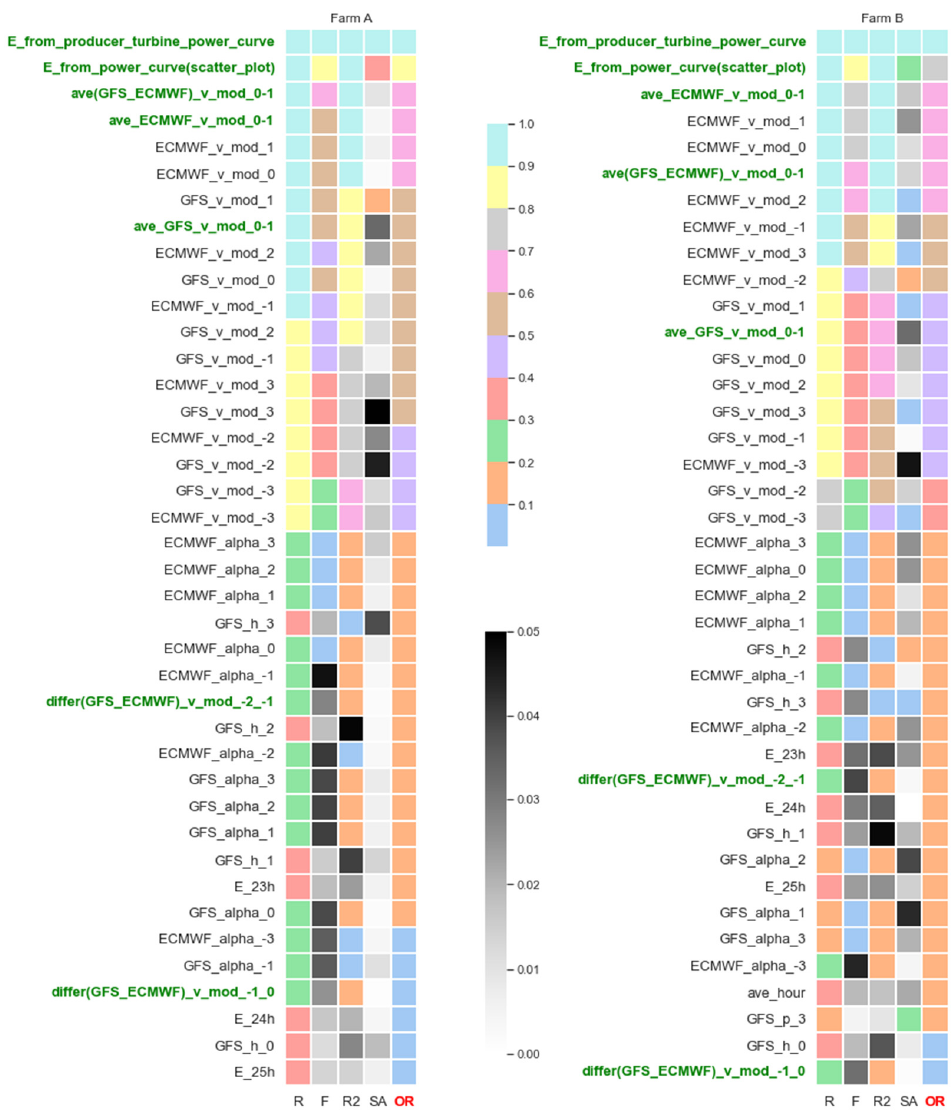
Figure 12. Results of sensitivity analysis of potential input variables including additional input data created for prediction models for Wind Farm A and Wind Farm B: 4 analysis methods and final Overall Rating (OR). Figure contains 40 best inputs out of 81. Names of additional inputs are marked green.